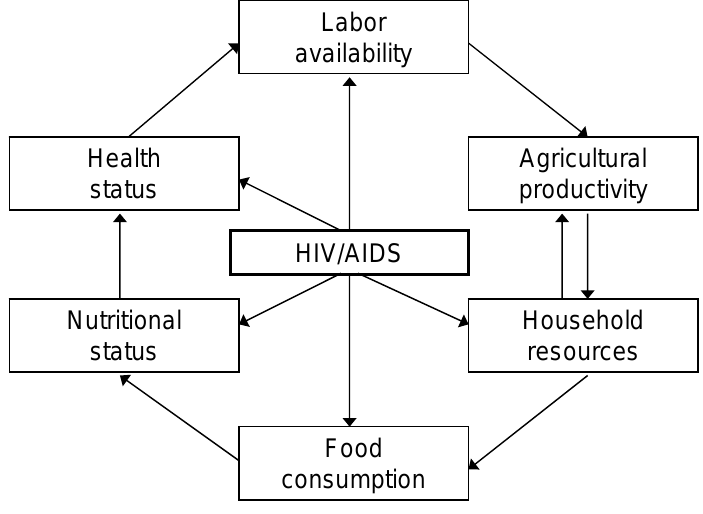
Figure 1. Model of the interrelationships between HIV/AIDS, labor, agriculture, food security, and